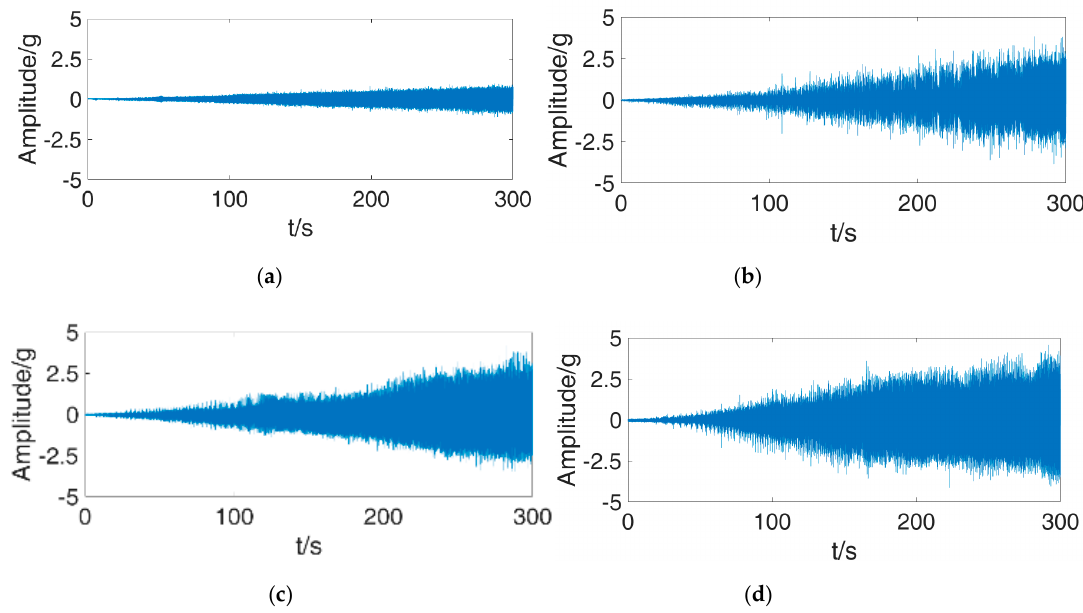
Figure 10. Vibration signals of four fault conditions. ( a ) normal ( b ) ball ( c ) inner race ( d ) outer race. To test the PSPP-CNN trained, the data of drive end accelerator in each condition are divided into 440 samples. Each sample contains 8192 data points. We get the cropped CWTS of each sample according to rotating speed. Therefore, the size of cropped CWTSs are ranges from 240 × 240 to 2400